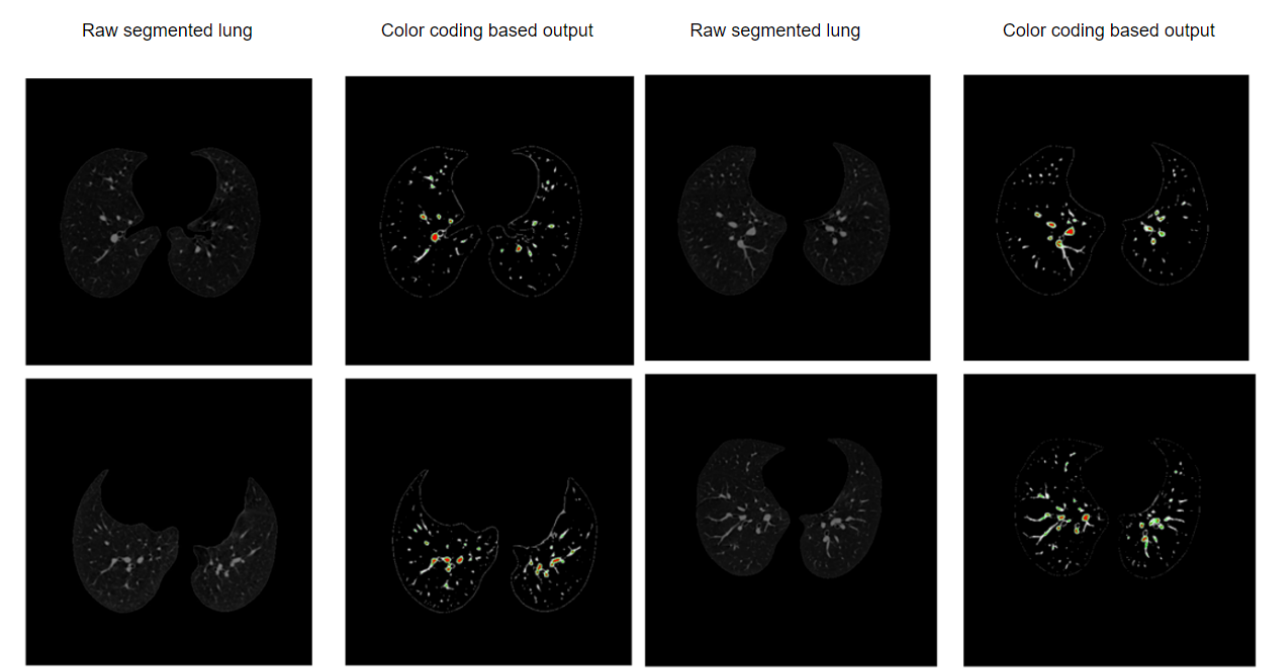
Figure 26. Sample outputs obtained with the color-coding-based approach.